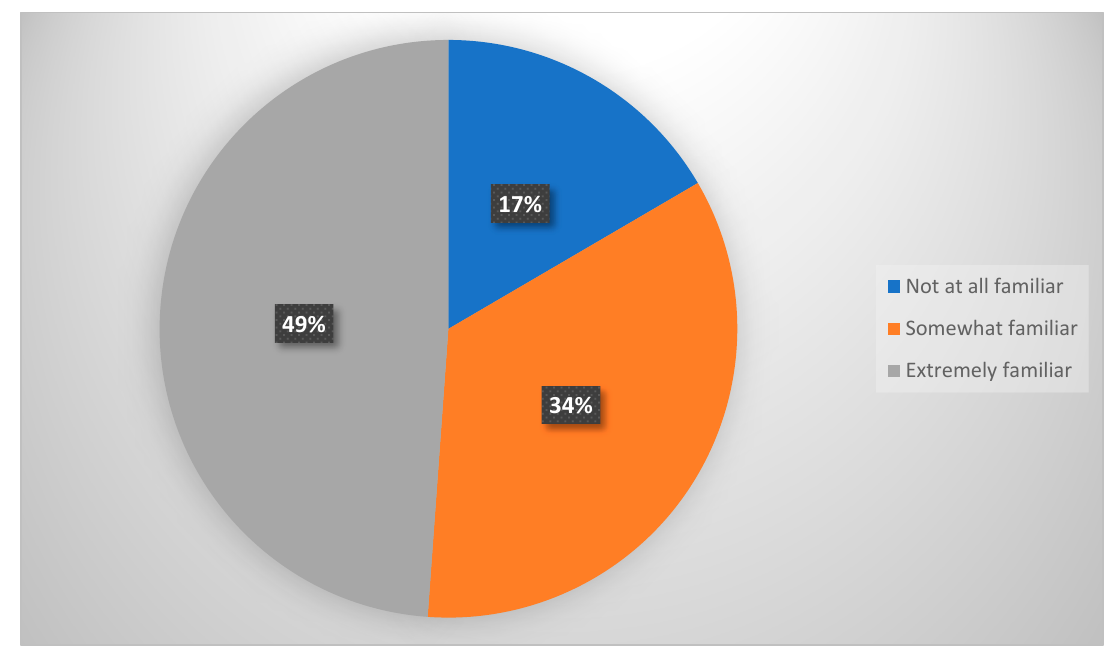
Figure 3. Parents’ awareness of schools’ precautionary measures against COVID-19.